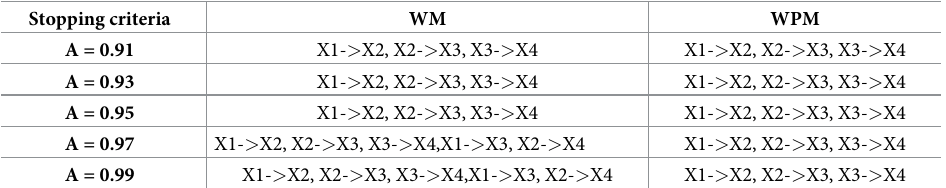
with different stopping criteria A. We can see that WPM detects only the direct interactions, while WM also